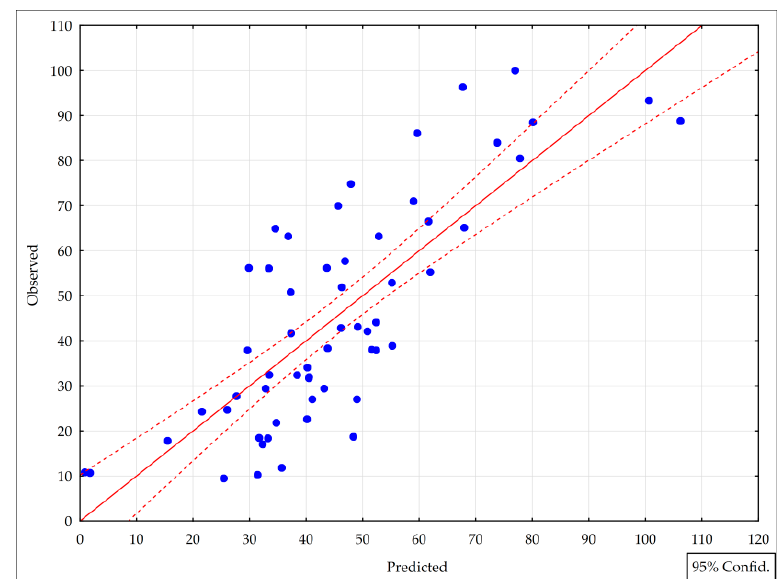
Figure 5. Relationship between observed soil moisture (SM) and calculated from Sentinel-1 VV data through statistically derived algorithm.